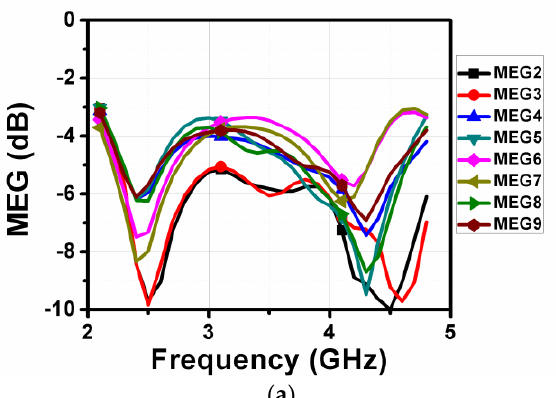
Figure 35. TARC of the 8-element communication antennas associated with ( a ) ports 2 to 9, ( b ) ports 10 to 17, and ( c ) ports 18 to 25.